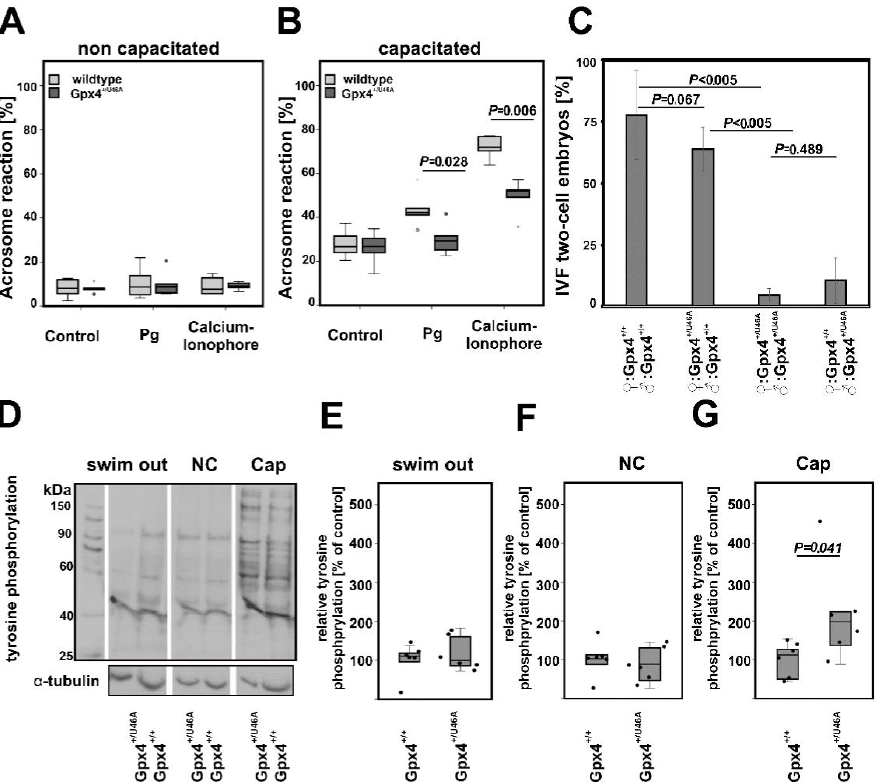
Figure 5. Heterozygous expression of catalytically inactive Gpx4 impairs the capability of the acrosome reaction and reduces the rate of in vitro fertilization. ( A , B ) In vitro acrosome reaction. Epididymal cauda sperm were extracted from wild-type mice and Gpx4 +/U46A animals. The acro- some reaction was induced in non-capacitated ( A ) and capacitated ( B ) sperm of the same sperm preparation with progesterone and calcium ionophore A23187. The extent of the acrosome reaction was quantified as described in “Materials and Methods”. The control panels show the degree of spontaneous acrosomal reaction in solvent-treated samples. Significances were calculated using the Mann–Whitney U test. The experiment was carried out with 5–6 different individuals. At least 200–300 stained cells per treatment were scored using an Axioskop microscope (Zeiss, Jena, Ger- many) with a 40 × objective clear field. Heads of sperm with the acrosome were stained dark blue (intact, not reacted acrosome) and without acrosome unstained (reacted acrosome). The percentage of capacitated and non-capacitated acrosome-reacted spermatozoa was calculated. p -values < 0.05 were considered statistically significant. ( C ) In vitro fertilization of wild-type (Gpx4 +/+ ) and Gpx4 +/U46A oocytes with sperm prepared from wild-type mice (Gpx4 +/+ ) and Gpx4 +/U46A animals. Cumulus- oocyte complexes (COCs) were isolated from stimulated (see “Materials and Methods”) female mice (Gpx4 +/+ and Gpx4 +/U46A ) and were fertilized in vitro with wild-type sperm (columns 1, 2) and with sperm prepared from U46A-Gpx4 +/ − mice (columns 3, 4) as described in “Materials and Methods”. After a 28 h incubation period, the relative shares of 2-cell embryos were quantified. The fertilization rates were calculated as the total number of 2-cell embryos divided by the total number of oocytes × 100. ( D ) Level of protein tyrosine phosphorylation during in vitro capacitation in sperm prepared from wild-type mice (Gpx4 +/+ ) and Gpx4 +/U46A animals. Total protein tyrosine phosphory- lation from protein extracts obtained from ( E ) freshly isolated (swim-out), ( F ) non-capacitated (NC), and ( G ) capacitated (Cap) spermatozoa as described in “Materials and Methods”. The intensities of the total protein tyrosine phosphorylation levels under the appropriate conditions were quantified using Image J and normalized to the respective intensity of alpha tubulin. The normalized values were further related to the corresponding control mice (Gpx4 +/+ ). Significances were calculated using the Mann–Whitney U test. The experiment was carried out with six different individuals of each